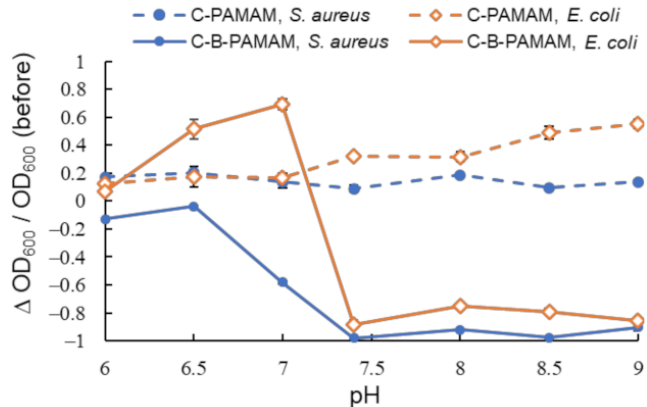
Figure 3. Turbidity changes in bacterial suspensions containing C-PAMAM and C-B-PAMAM in PBS buffer ( n = 3). [probe] = 3.3 µ M; [bacteria] = 2.3 × 10 8 CFU · mL − 1 . Bars are expressed as SD for three separate experiments. The number of alkyl chain modifications was 10 and that of boronic acid modifications was